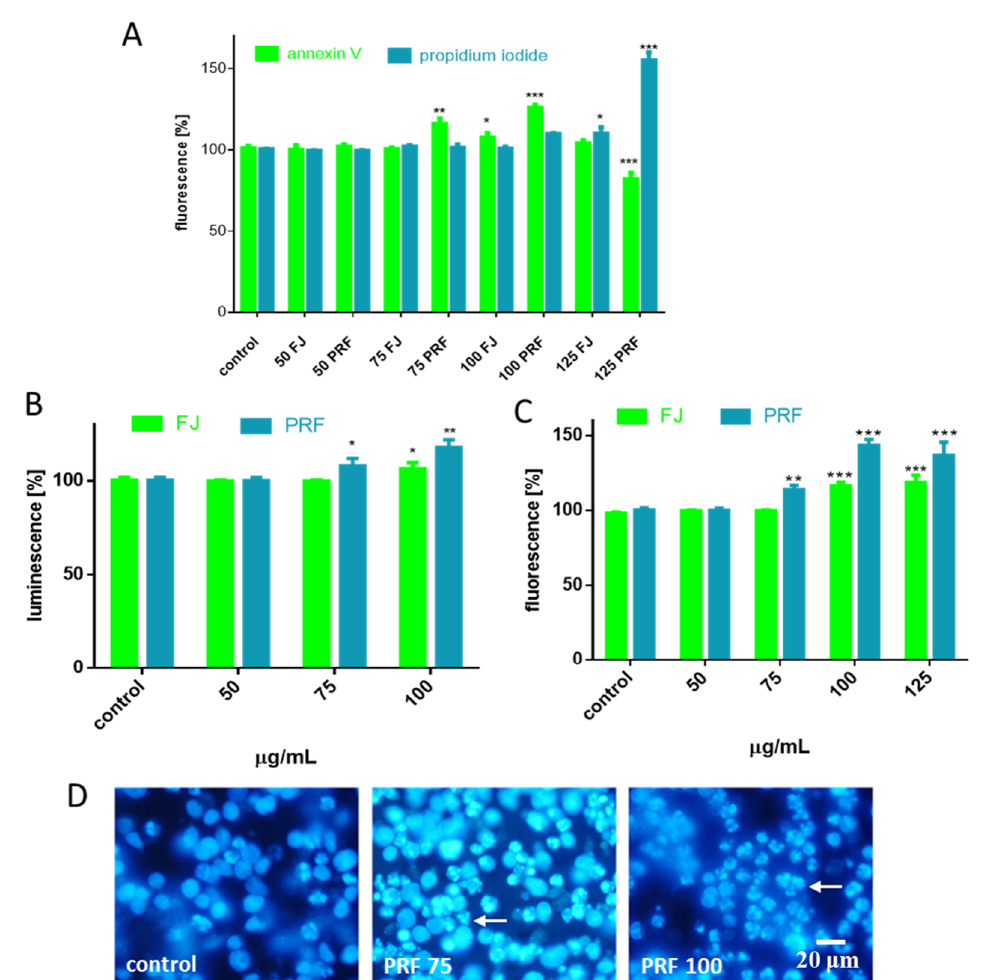
Figure 4. The influence of 24 h of exposure of FJ and PRF on phosphatidylserine externalization